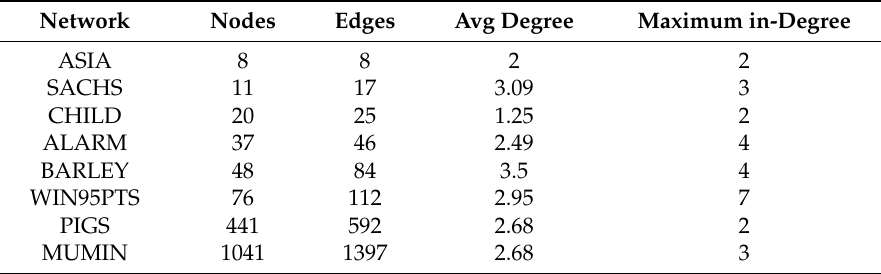
Table 2. Statistics on the